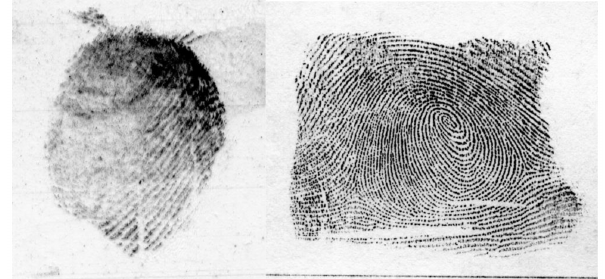
Figure 1. Sample fingerprint images used in the study. The image on the left is a latent print. Note large areas of the image that are smudged or missing. Contrast and ridge clarity vary greatly across the fingerprint area. These and other aspects of the image could make comparison difficult. The image on the right is a known print and is much